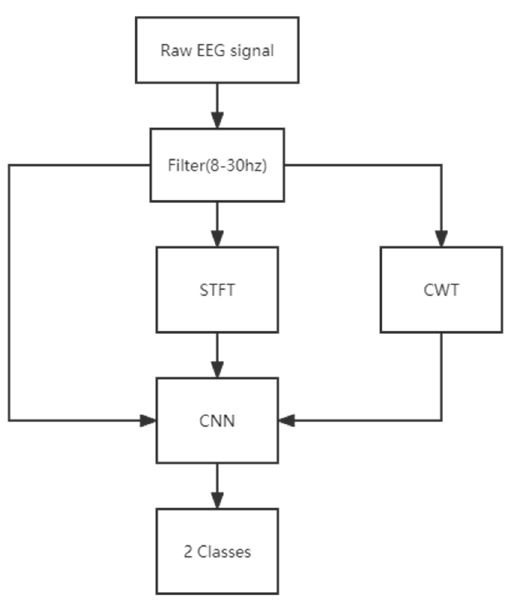
Figure 3. The flowchart of the EEG data processing on the laptop.